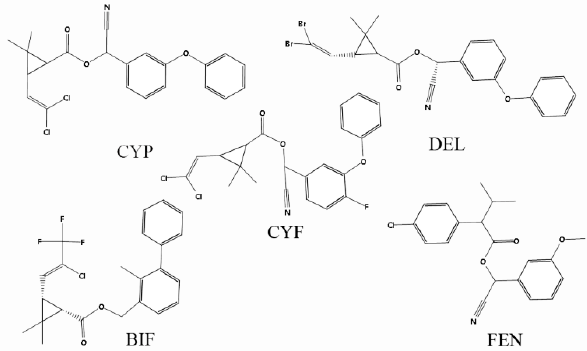
Figure 7. The Chemical structure of CYF and its structural analog.